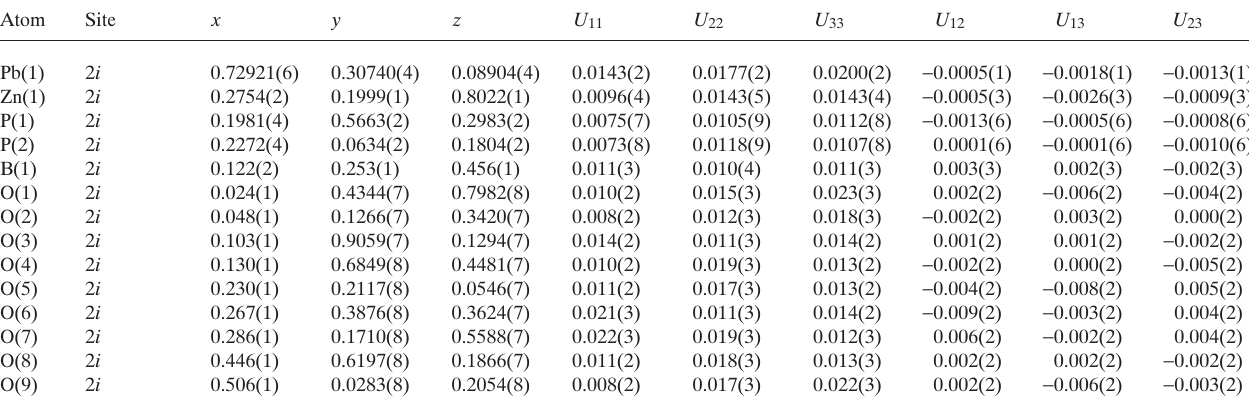
Table 5. Atomic coordinates and displacement parameters (in Å 2 ) .